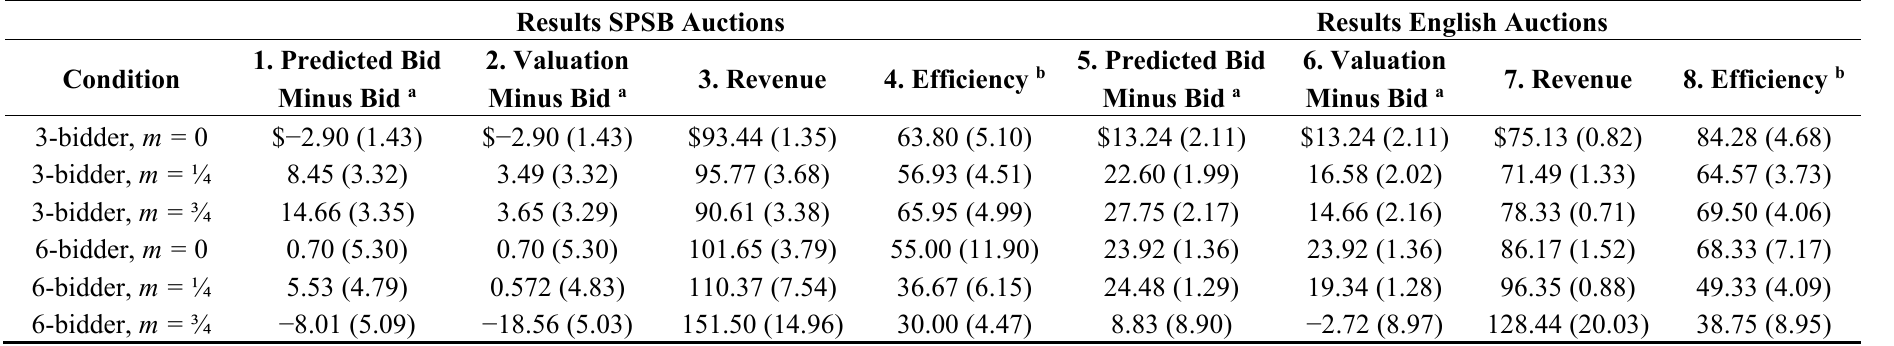
Table 2. Comparison of SPSB and English auctions for different conditions (multipliers and number of bidders) (Standard errors in parentheses).